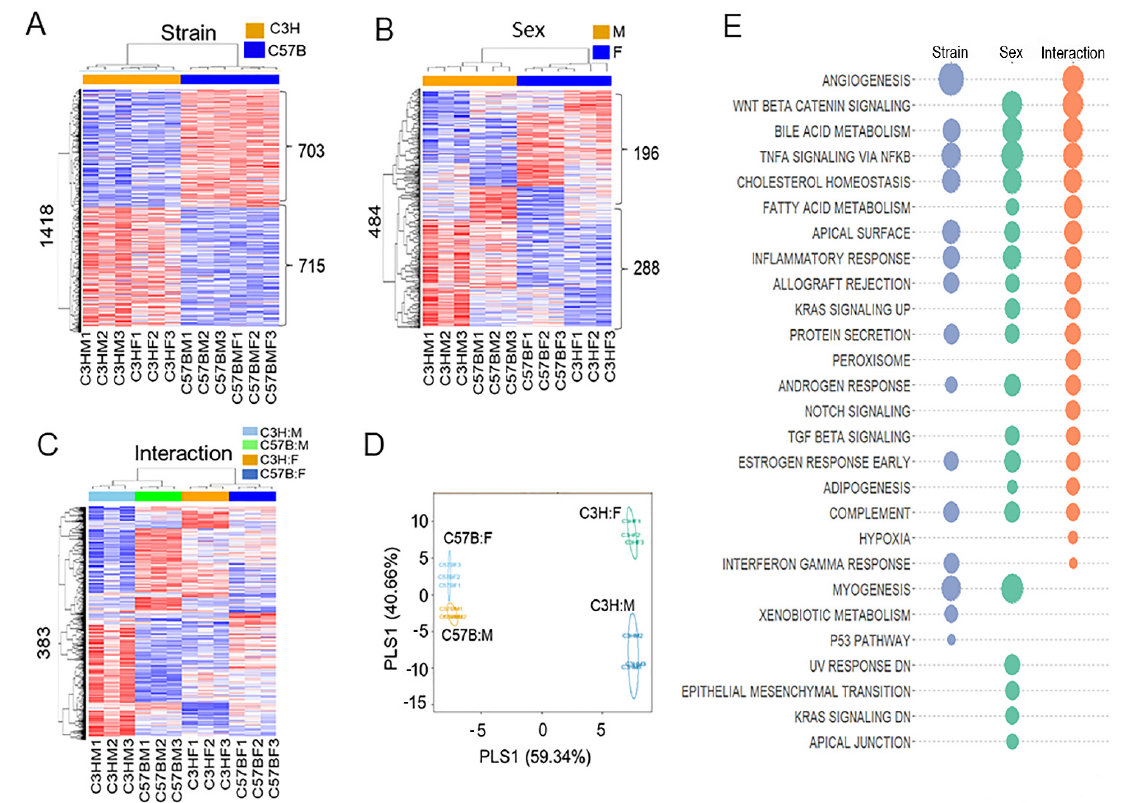
Figure 3. Differentially expressed transcripts. The results of two-way hierarchical clustering presented as heatmaps for ( A ) strain, ( B ) sex, and ( C ) interactions. ( D ) PLS-DA score plot for high-resolution transcriptomic data resulting in strain, sex, and interaction. ( E ) Gene set enrichment analyses among strain, sex, and interactions as a bubble plot with bubble size corresponding to the size of the log value ( p < 0.05).